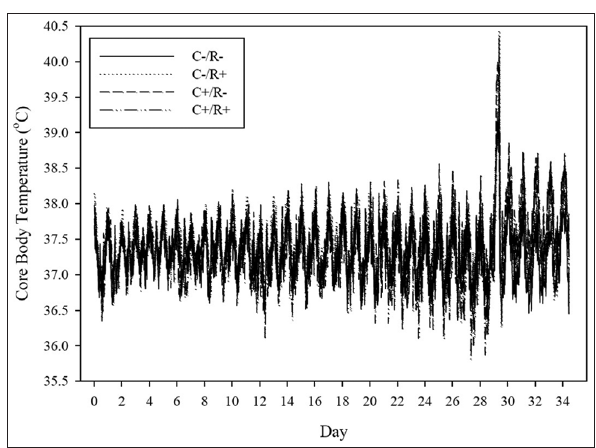
Figure-1: Mean (±SE) core body temperature of rats maintained under thermoneutrality (ambient temperature; T =23.15±0.04°C) was maintained between days 0 a and 28. Then, heat stress (HS) was imposed in two subsequent phases; an acute HS wave (T =35.86±0.37°C; a 00:00-09:00 h) on day 29 of the trial, followed immediately by chronic HS (T =32.28±1.00°C); until the end of the a trial (day 34). The treatments were hypercholesterolemia- inducing (HC) diet (C+) and/or resveratrol (R+): C-/R- (control) group fed a control diet throughout the trial. The C+/R- group consumed the HC diet (containing 1% purified cholesterol along with 0.5% cholic acid, with high- fat-based mixture), throughout the trial. The C-/R+ was fed the control diet and received a dose of 13 mg/kg BW/day of purified trans-resveratrol by oral gavage during the past 5 days of the trial. The C+/R+ group consumed the HC diet and received the R+ treatment as explained.